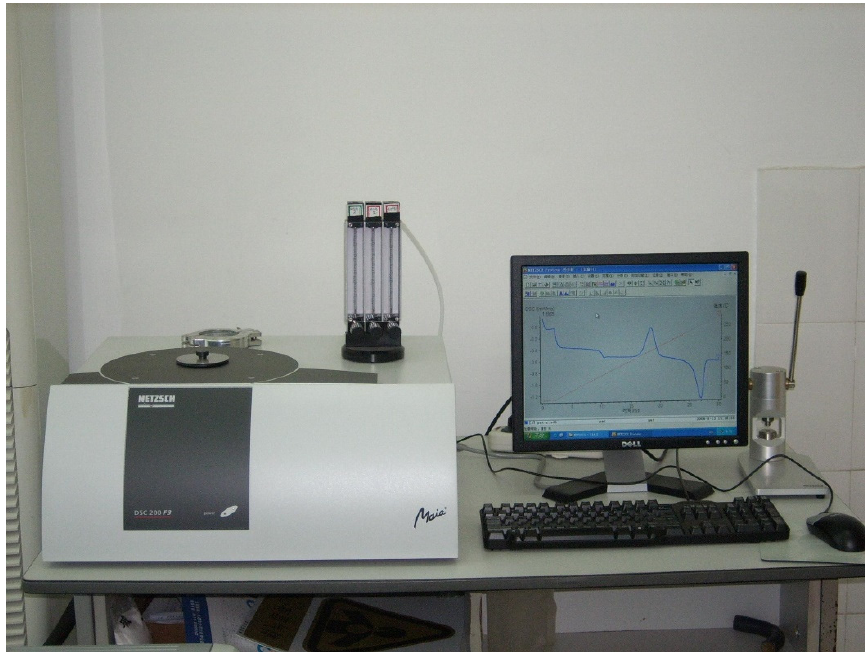
Figure 2. STA449F3 synchronous thermal analyzer.